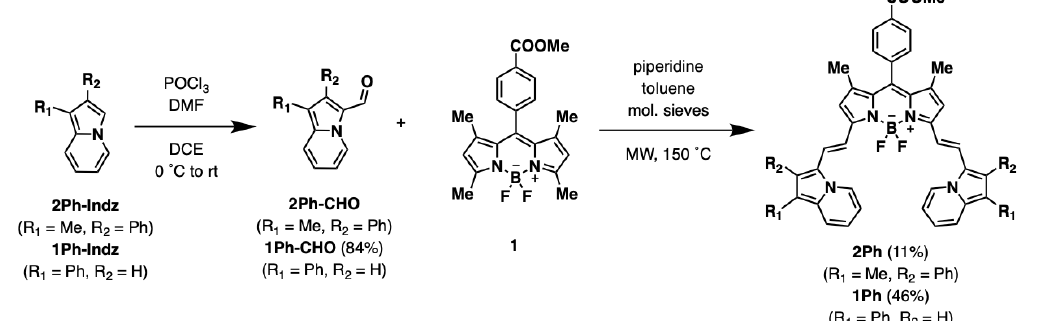
Table 1. Photophysical data for BODIPY dyes in CH 2 Cl 2